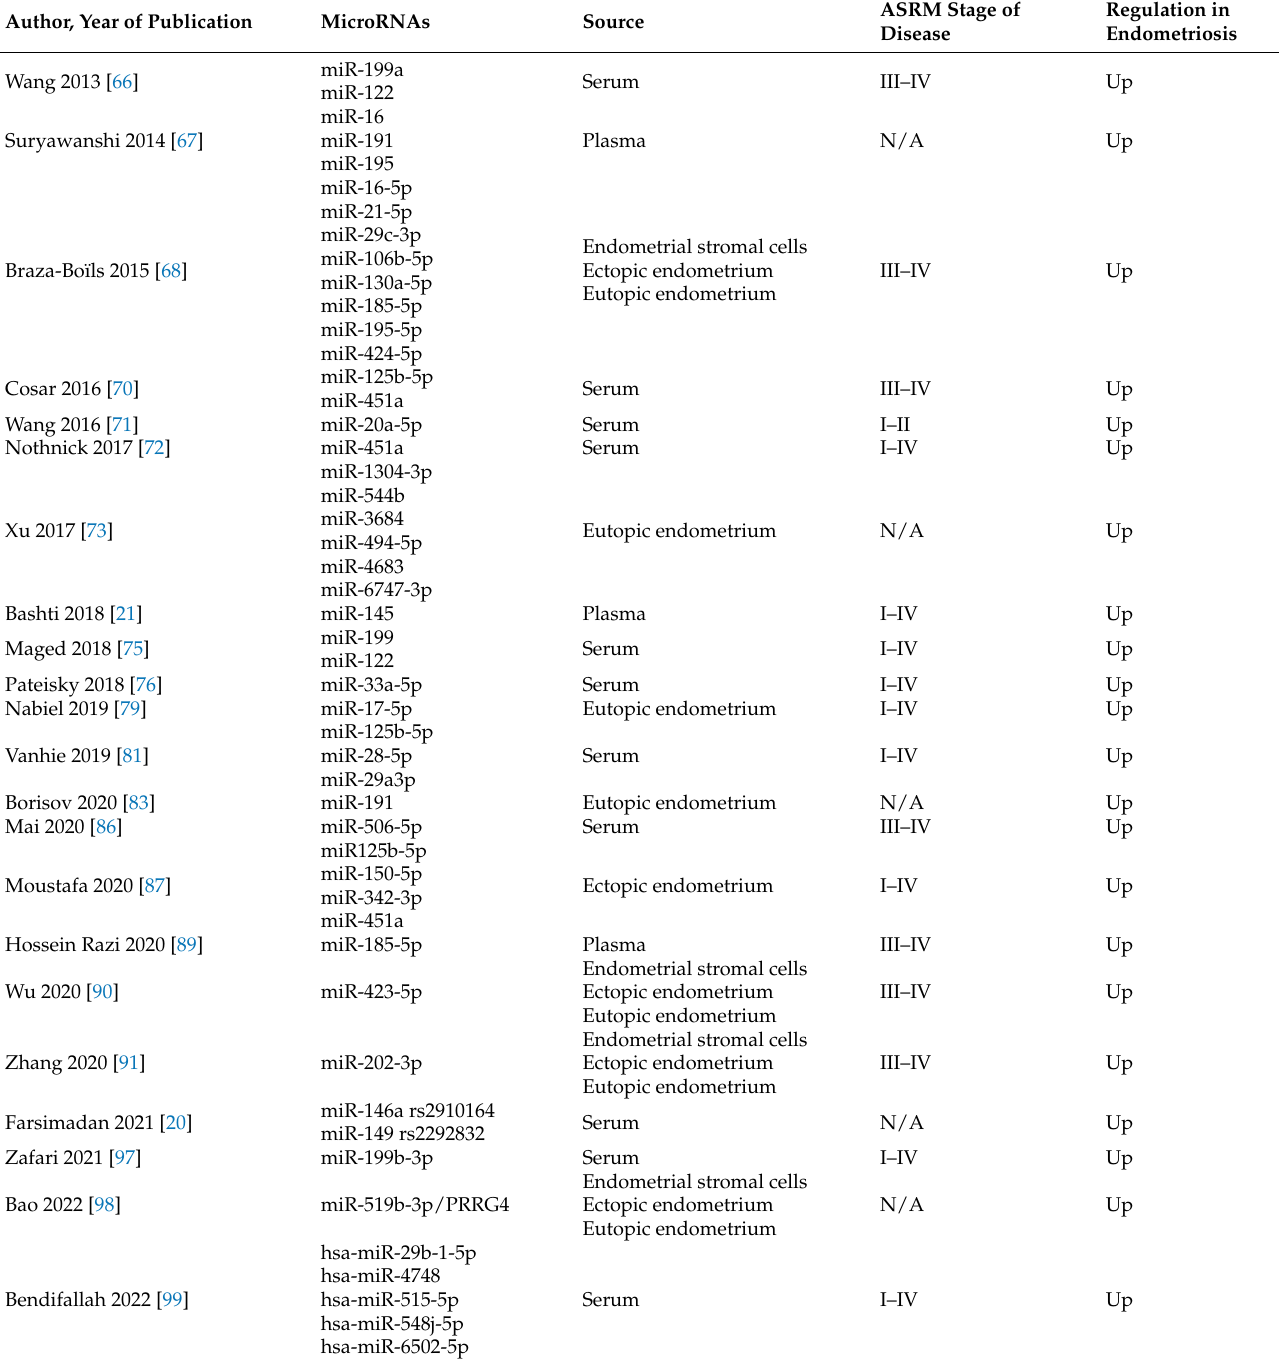
Table 2. Upregulated microRNA expression profiles in patients with